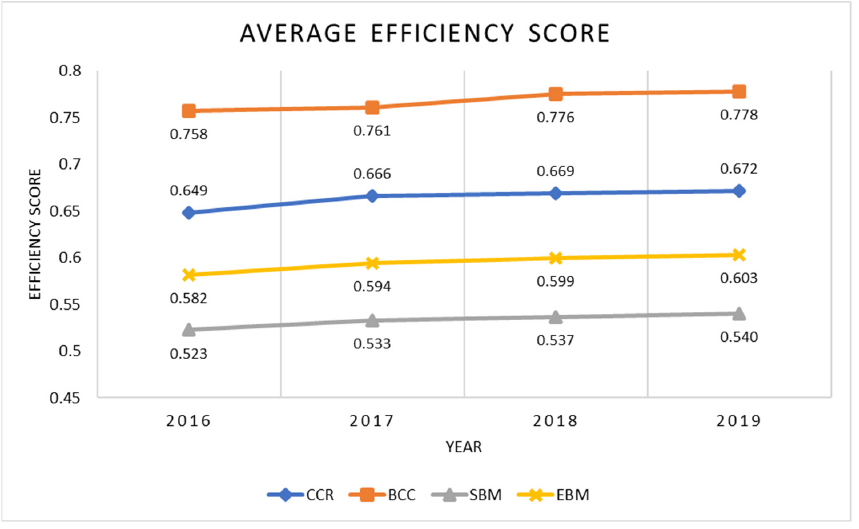
Figure 7. Comparative chart of methods.